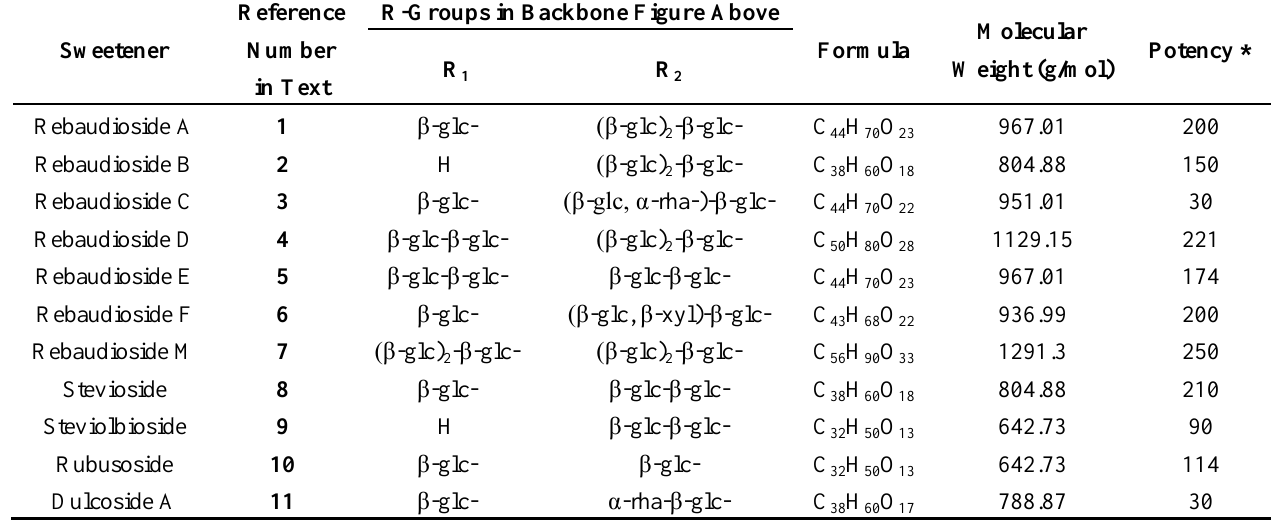
Table 1. R-groups, molecular formulas, molecular weights and potencies of the Stevia